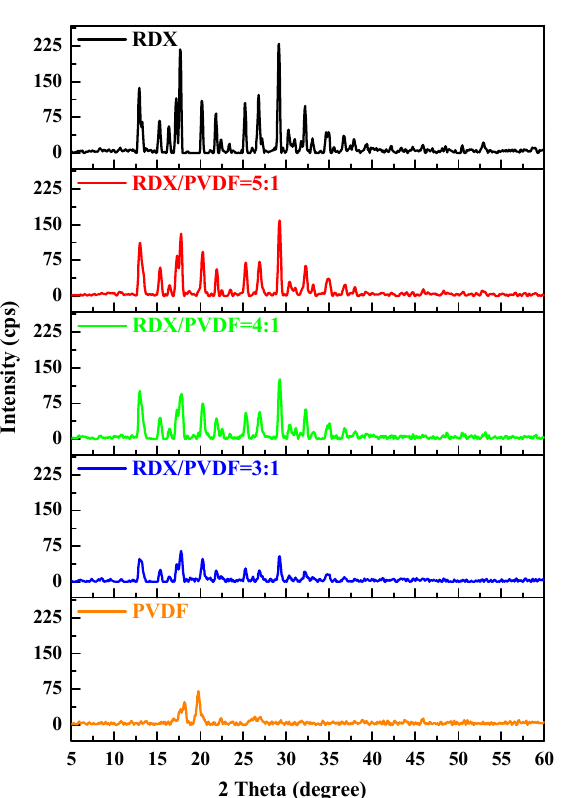
Figure 2. X-ray Diffraction patterns of raw RDX and RDX@PVDF